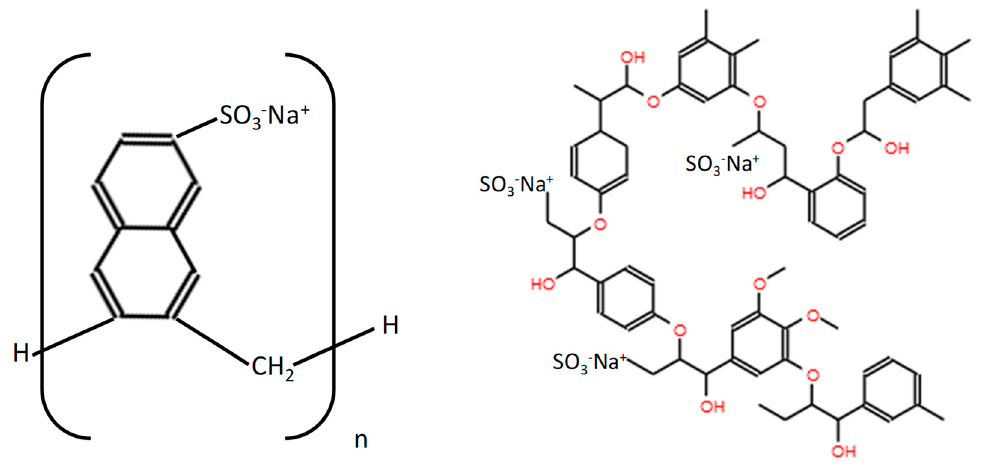
Figure 4. Molecular structure of the two tested polymers: PNS ( left ) and LS ( right ).